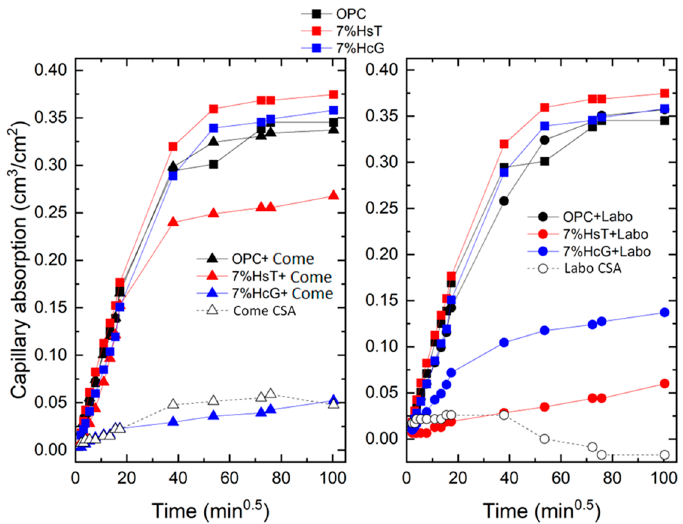
Figure 2. Capillary water absorption measurements for the mortars, employing the square root of the time.